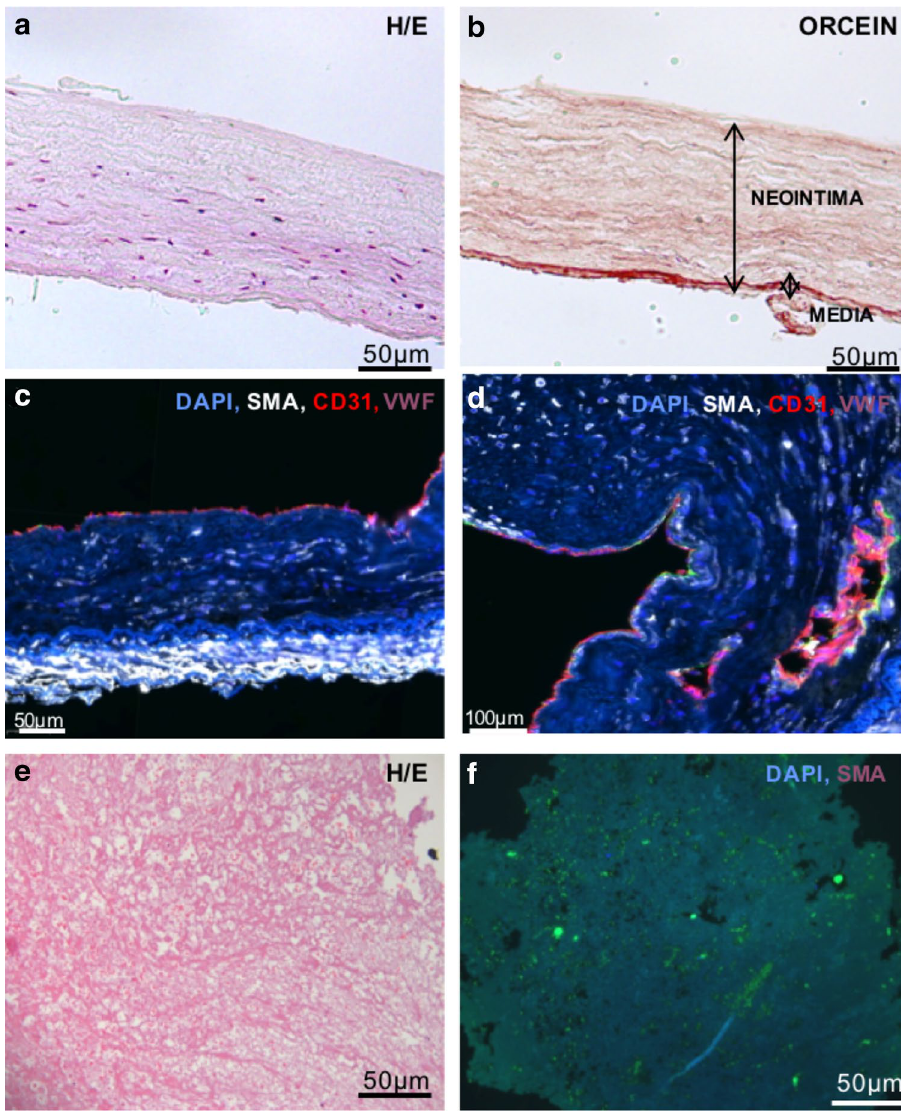
Figure 1. PEA samples. ( a , b ) Specimens collected during PEA from CTEPH patients were stained by hematoxylin and eosin and stained for elastin by orcein stain. ( c ) PEA samples presented an intact endothelium as shown by endothelial markers CD31 and vWF, an enlarged α-SMA negative neointima and an α-SMA positive organized media. ( d ) PEA samples showed the presence of mature microvessels. ( E – f ) Coagulant material showed a fibrous structure lacking